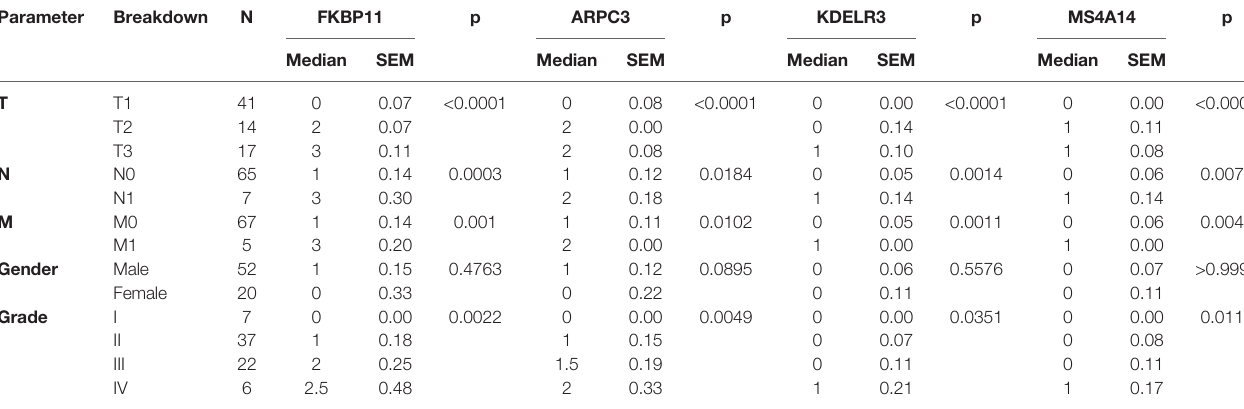
TABLE 2 | Association of with clinicopathological parameters of ccRCC patients in the IHC validation cohort. Parameter